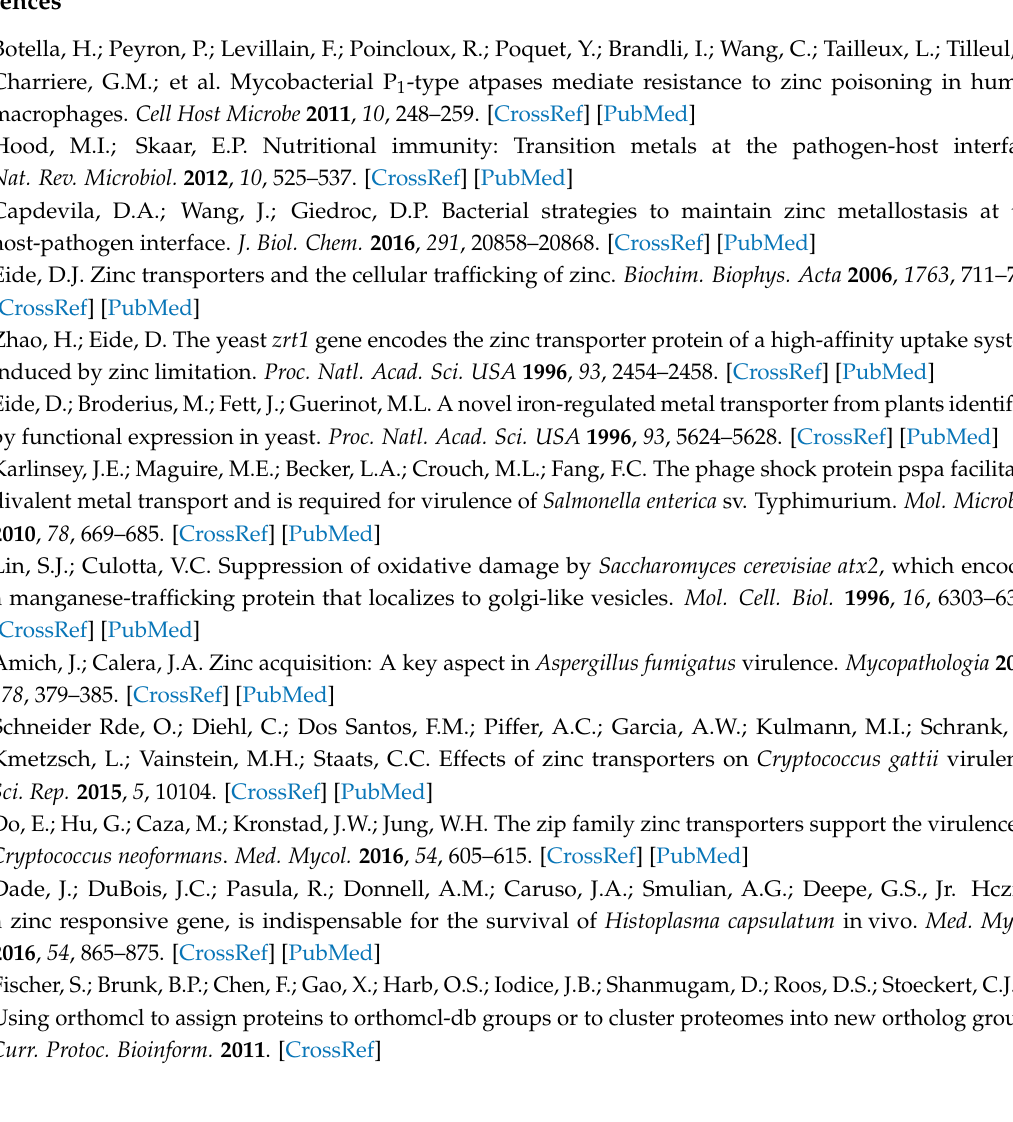
Table S1. ZIP and zincophore gene synteny. Table lists the presence (denoted by respective accession numbers) or absence (N) of PRA1 and ZRT1 orthologues in 102 fungal species (NCBI). In species where both genes are present, column 4 indicates syntenic (Y), or non-syntenic (N)